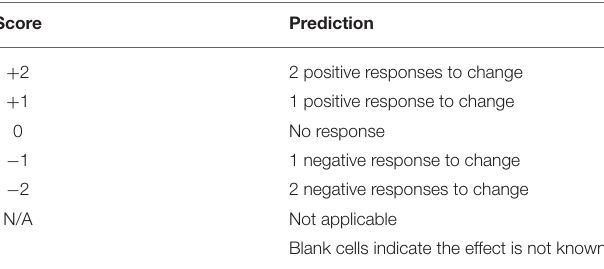
TABLE 1 | Description of climate risk factors. Ocean acidification